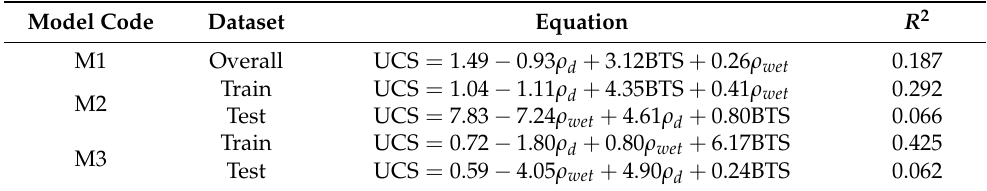
Table 6. Multiple linear regression analysis for UCS in MPa; ρ d (g/cm 3 ), BTS (MPa), and ρ wet (g/cm 3 ) are the dry density, Brazilian tensile strength, and wet density,